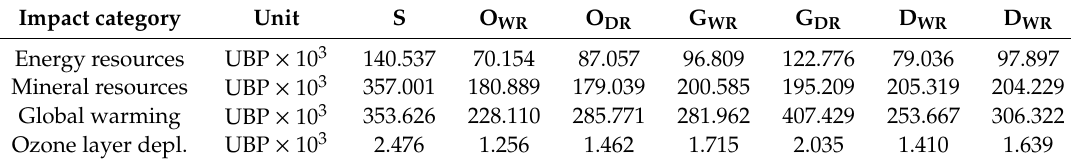
Table 9. Wearing courses: results of selected impact categories.